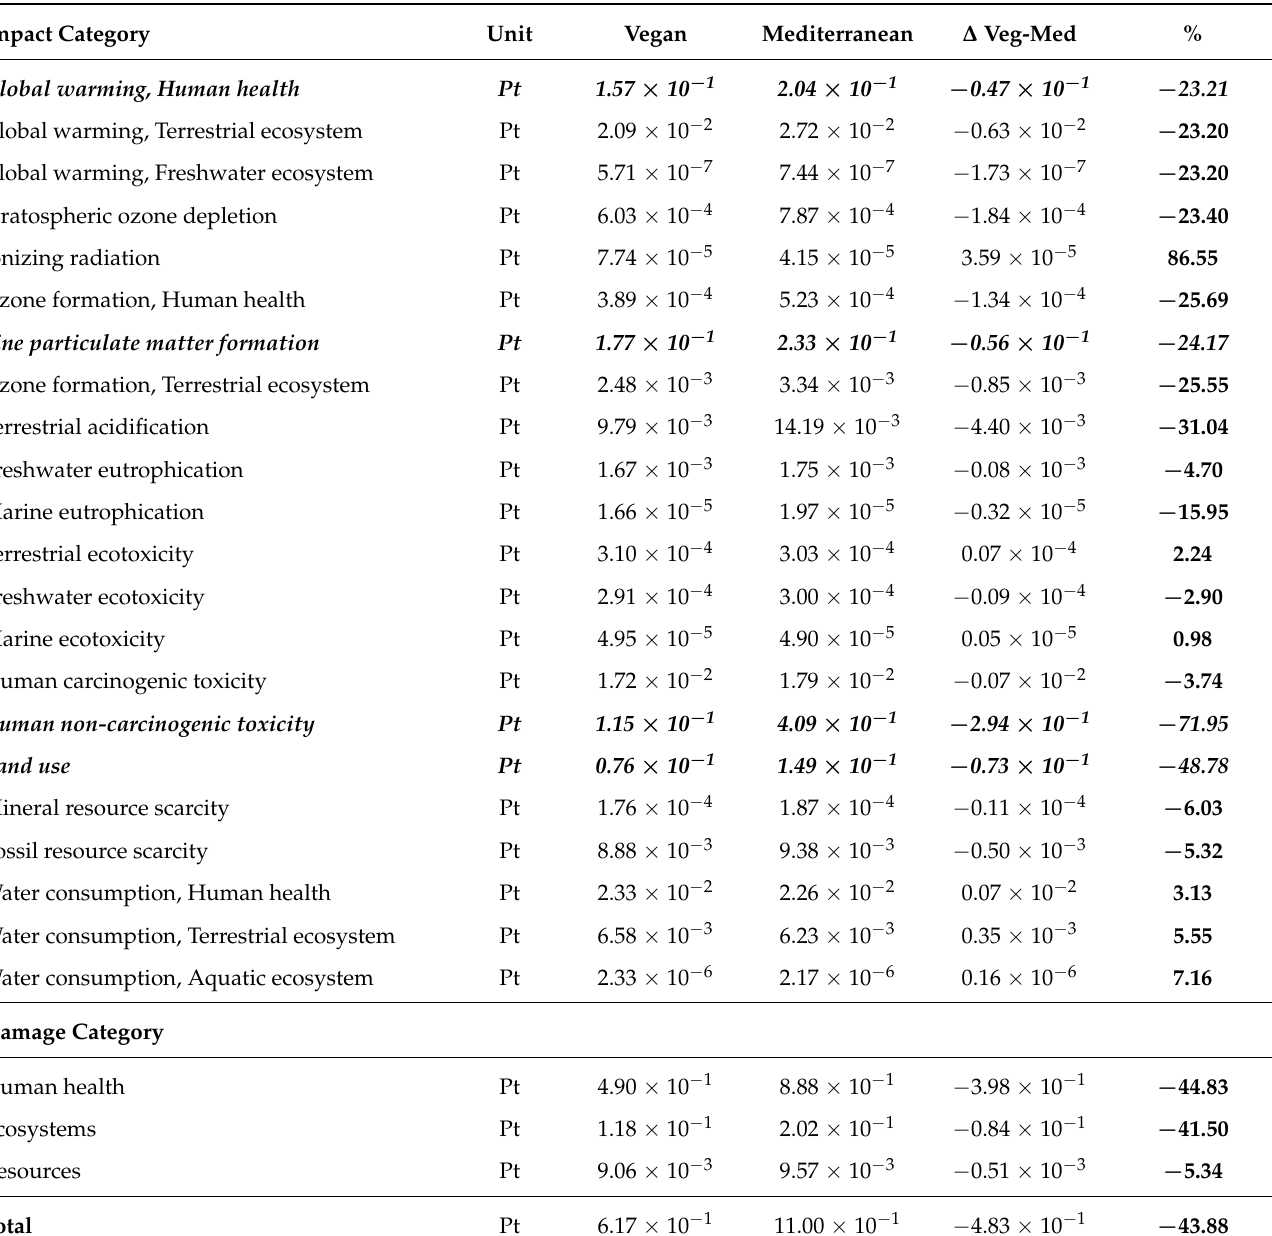
Table 3. Total Environmental Impact of Vegan and Mediterranean diets: Impact Categories and Damage Categories. Aggregated Weighted Average: total environmental load expressed as a Single Score (mPt =